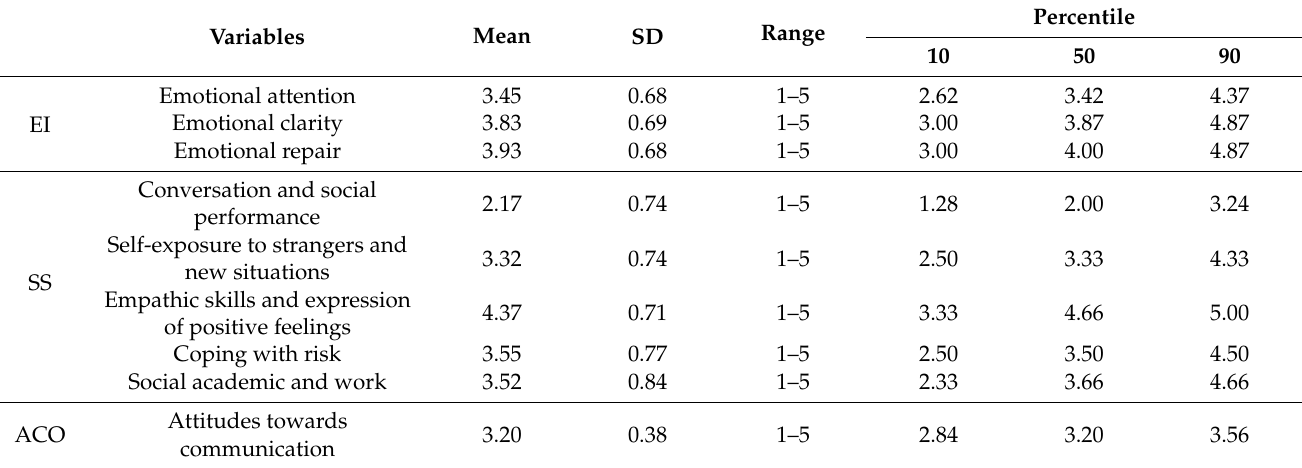
Table 1. Descriptive statistics for professionals.